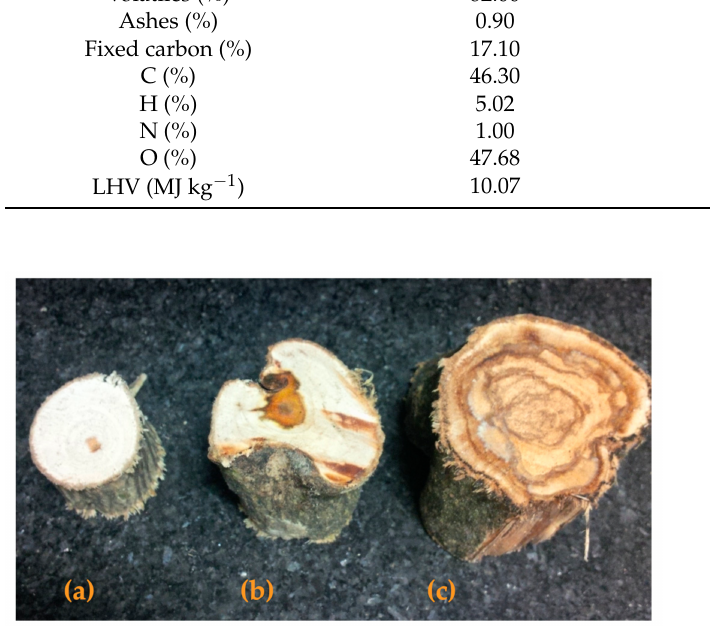
Figure 3. Specimens of C. striatus aged: ( a ) 3 years; ( b ) 4 years; and ( c ) 6